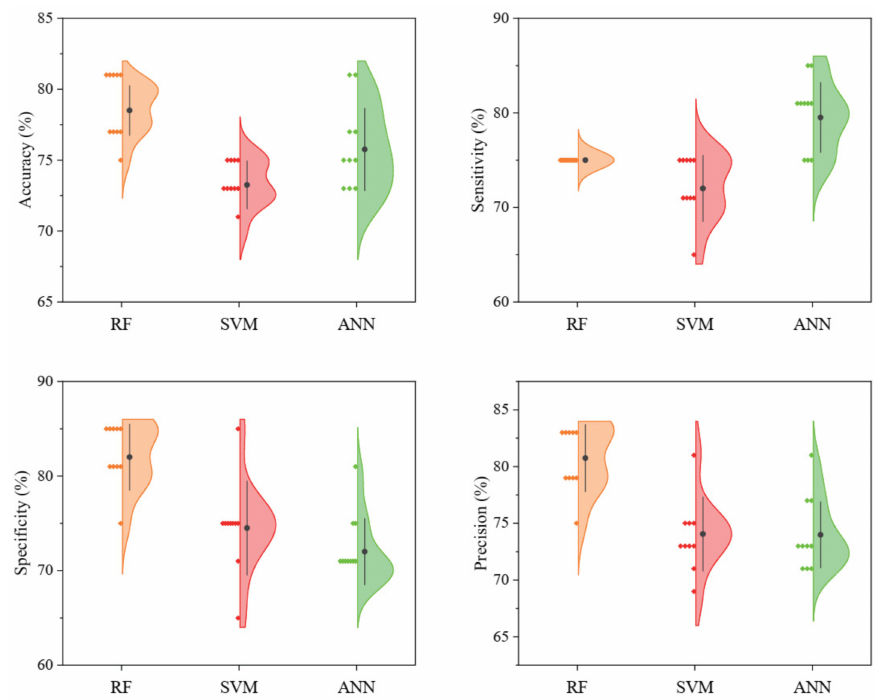
Figure 7. Performance of the classification models based on SVIs. The black dots represent the mean, and the black lines represent the mean ±